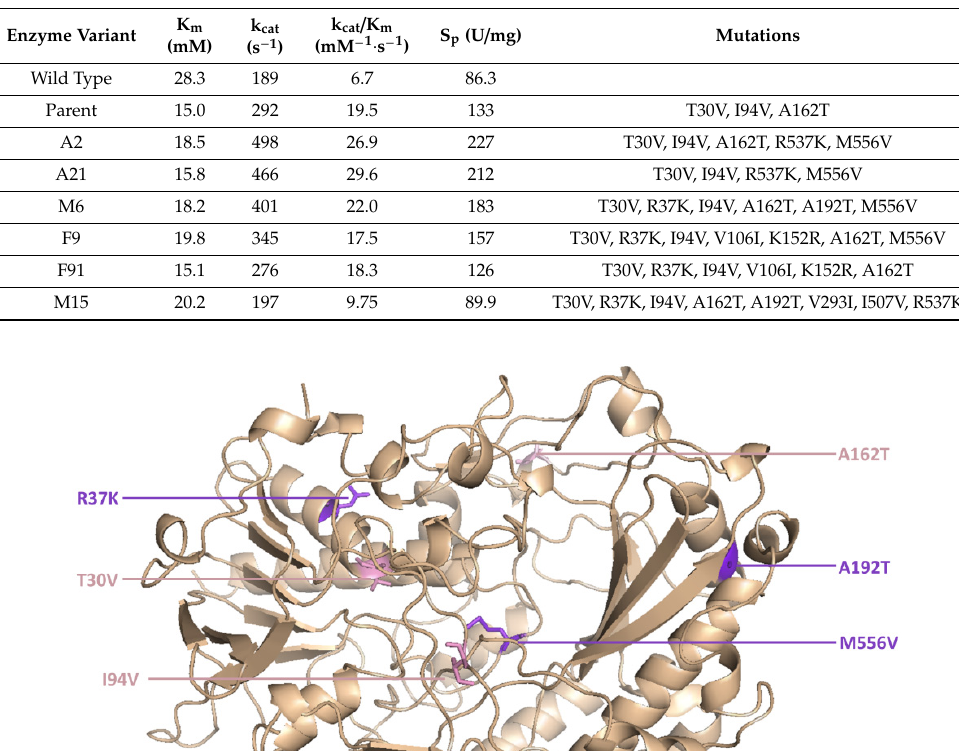
Table 1. Kinetic parameters of isolated mutants compared to wild-type glucose oxidase.